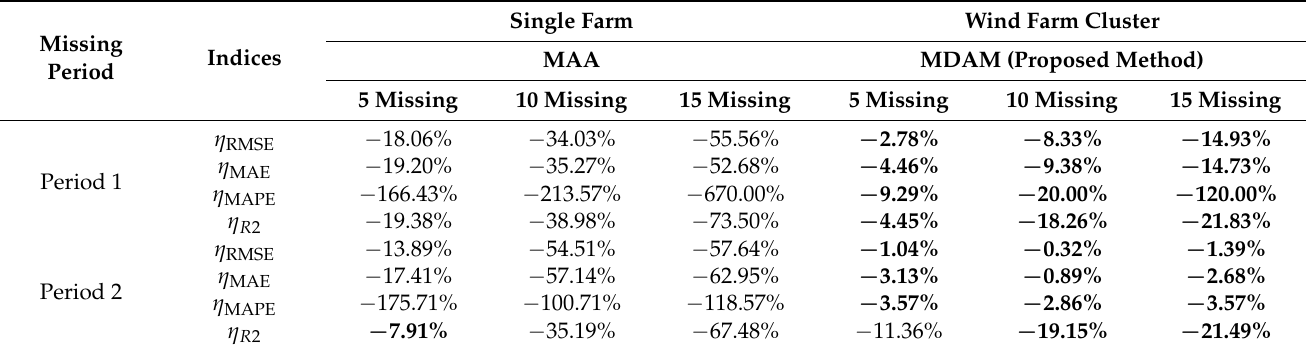
Table 7. Improvement of single-farm and wind farm cluster prediction in different conditions of missing data *.